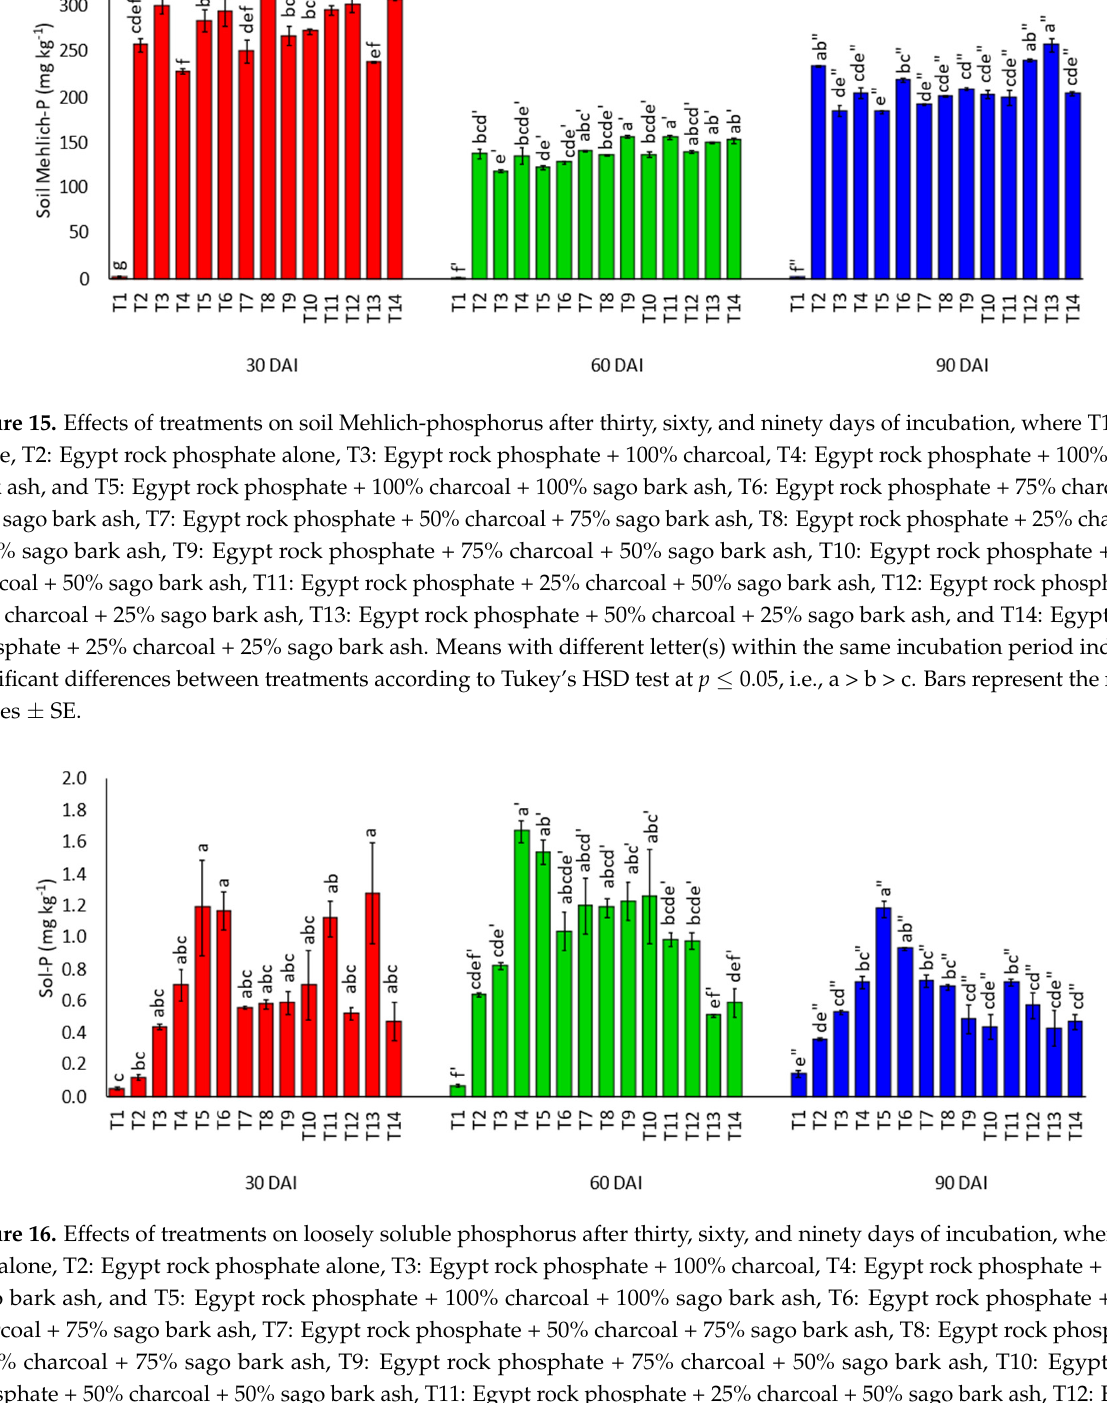
15 of 28 Figure 14. Effects of treatments on soil total phosphorus after thirty, sixty, and ninety days of incu- bation, where T1: soil alone, T2: Egypt rock phosphate alone, T3: Egypt rock phosphate + 100% charcoal, T4: Egypt rock phosphate + 100% sago bark ash, and T5: Egypt rock phosphate + 100% charcoal + 100% sago bark ash, T6: Egypt rock phosphate + 75% charcoal + 75% sago bark ash, T7: Egypt rock phosphate + 50% charcoal + 75% sago bark ash, T8: Egypt rock phosphate + 25% charcoal + 75% sago bark ash, T9: Egypt rock phosphate + 75% charcoal + 50% sago bark ash, T10: Egypt rock phosphate + 50% charcoal + 50% sago bark ash, T11: Egypt rock phosphate + 25% charcoal + 50% sago bark ash, T12: Egypt rock phosphate + 75% charcoal + 25% sago bark ash, T13: Egypt rock phosphate + 50% charcoal + 25% sago bark ash, and T14: Egypt rock phosphate + 25% charcoal + 25% sago bark ash. Means with different letter(s) within the same incubation period indicate signif- icant differences between treatments according to Tukey’s HSD test at p ≤ 0.05, i.e., a > b > c. Bars represent the mean values ± SE. Soil Mehlich-P demonstrated a different trend compared with soil total P (Figure 15). Regardless of incubation period, soil Mehlich-P of T1 was the lowest among the treat- ments. The effects of the treatments with ERP, charcoal, and sago bark ash (T2, T3, T4, T5, T6, T7, T8, T9, T10, T11, T12, T13, and T14) on soil Mehlich-P were higher at 30 DAI, de-